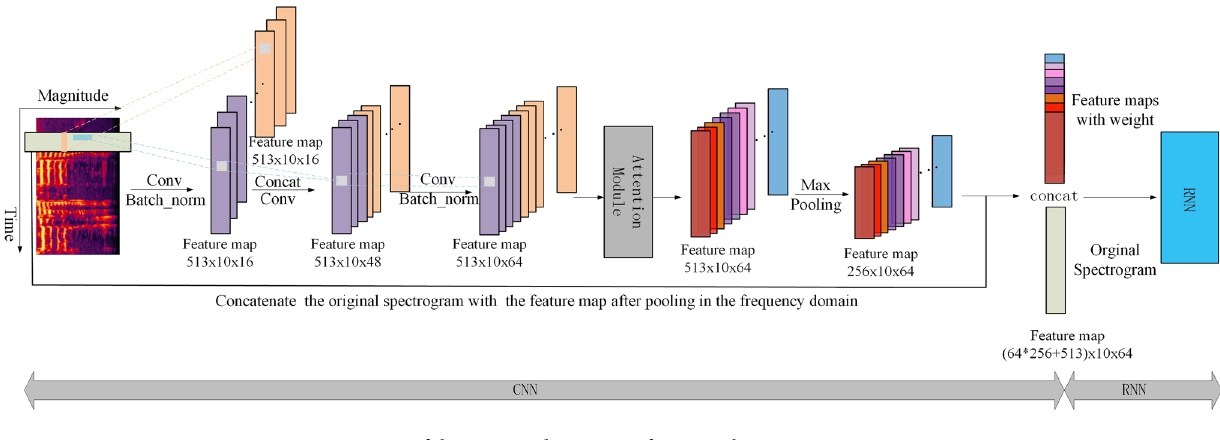
Figure 2. Structure of the proposed CRNN-A